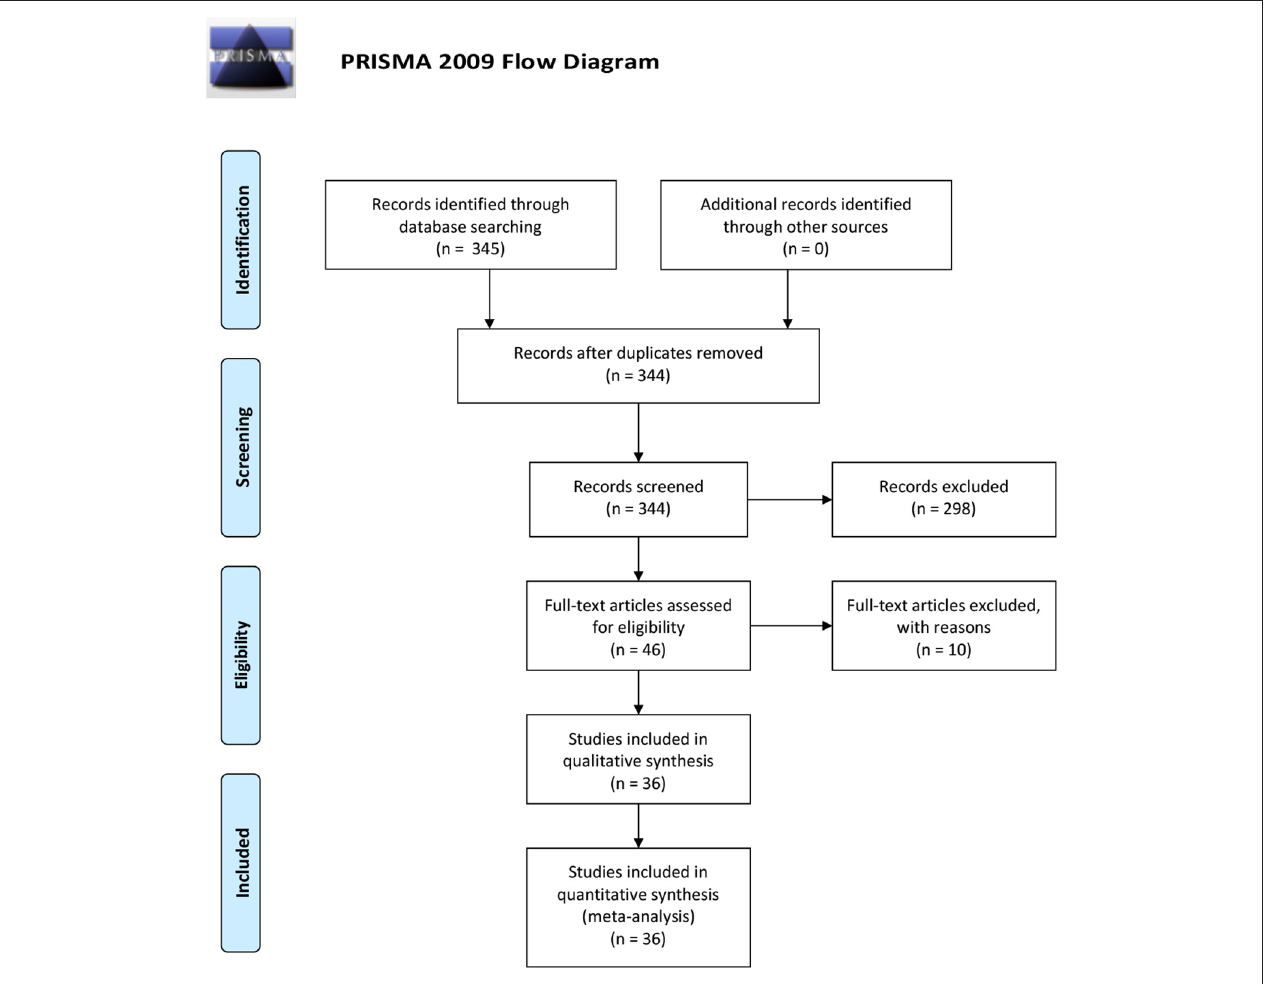
FIGURE 1 | PRISMA diagram according to Moher et al.